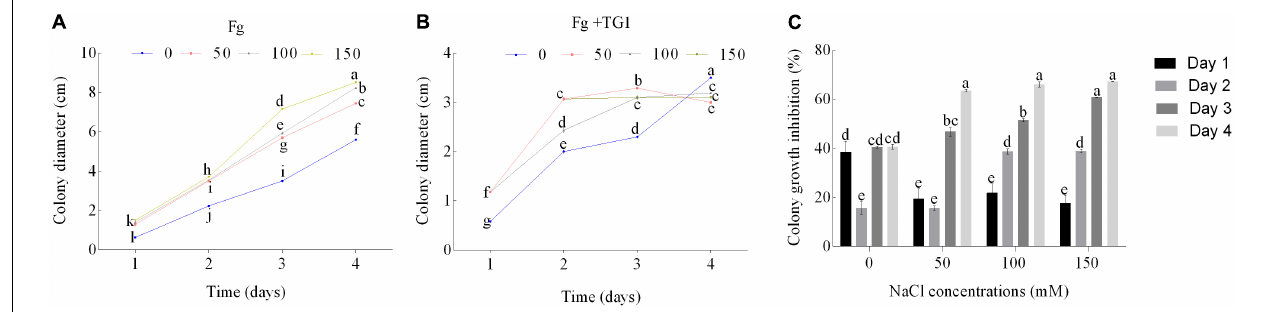
FIGURE 1 | Effect of T. longibrachiatum (TG1) and salt stress on F. pseudograminearum (Fg) growth. (A) colony diameter of Fg only, (B) colony diameter of Fg after inoculation with TG1, and (C) colony growth inhibition of TG1 against Fg under different salt stresses (0, 50, 100, and 150 mM NaCl) at different days. Different lower case letters indicate significant differences at P < 0.05 in Duncan’s multiple range test using two-way